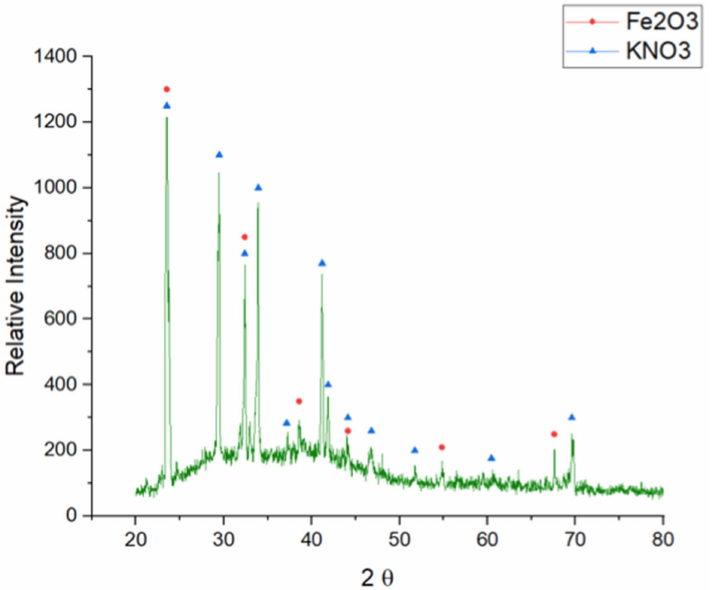
Figure 5. XRD analysis for A516 after 1000 h of immersion in LiNO 3 ternary molten salt at 390 ◦